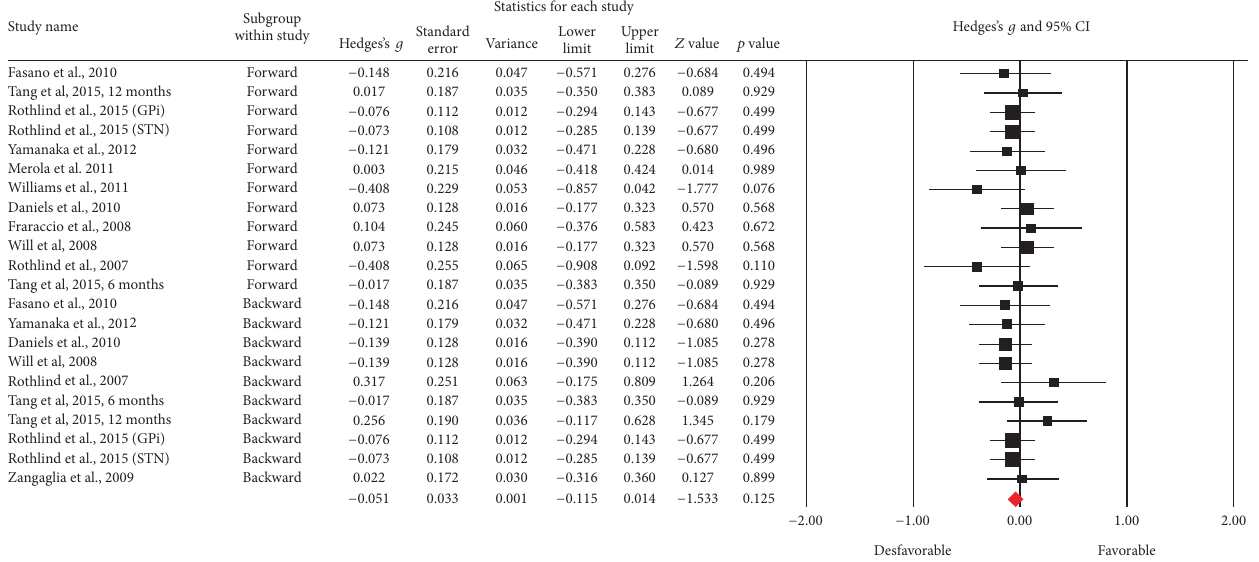
Hedges’s g Funnel plot of standard error by